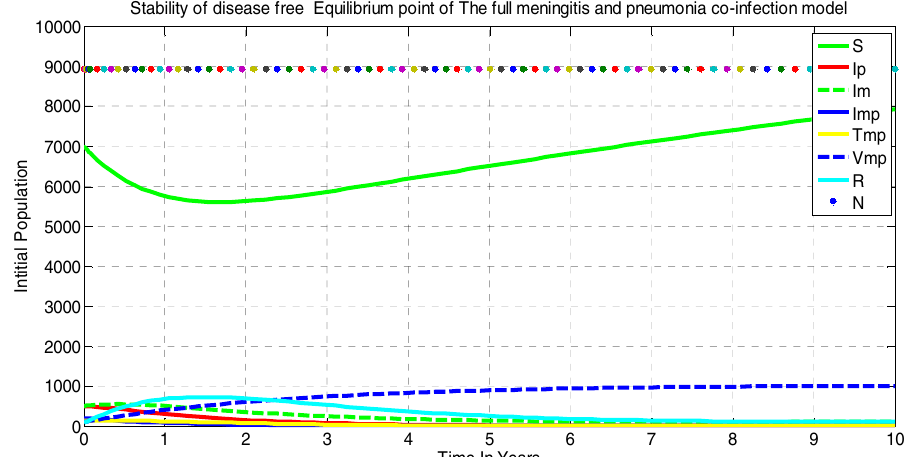
Figure 2. The stability of the disease-free equilibrium point (DFE).